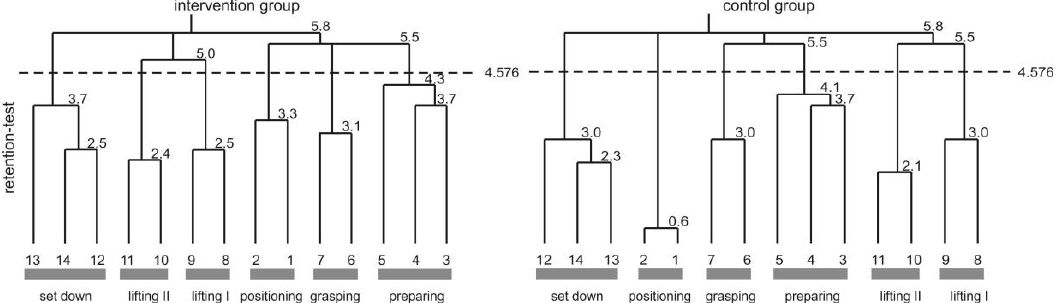
Figure 5. The cognitive representation of the box lifting technique displayed as average cluster solutions of the BACs 1–14 for the intervention and the control group at retention test. The numbers at the bottom represent the used BACs. The Euclidian distances between the BACs is indicated at the conjunctions between BACs. The lower the number at the conjunctions, the lower the Euclidian distances between these BACs. The lower the distance, the stronger the connection between these BACs in long-term memory. The dashed line represents the critical Euclidian distance (dcrit = 4.576 with an error probability of p = 0.01) where all branches of the dendrogram were cut-off. BACs connected to one branch below the critical Euclidian distance are clustered. Evolved clusters are indicated by grey bars at the bottom of each dendrogram. The cluster represented functional movement phases named below the grey bars.